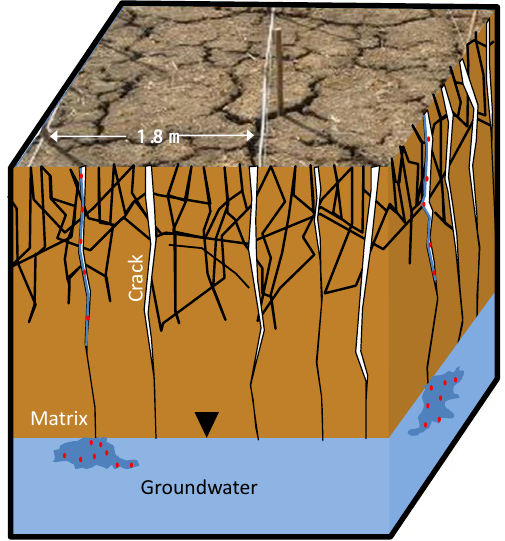
Figure 1. Illustration of potential fluxes of water and pollutants that bypass the matrix, which is typical of